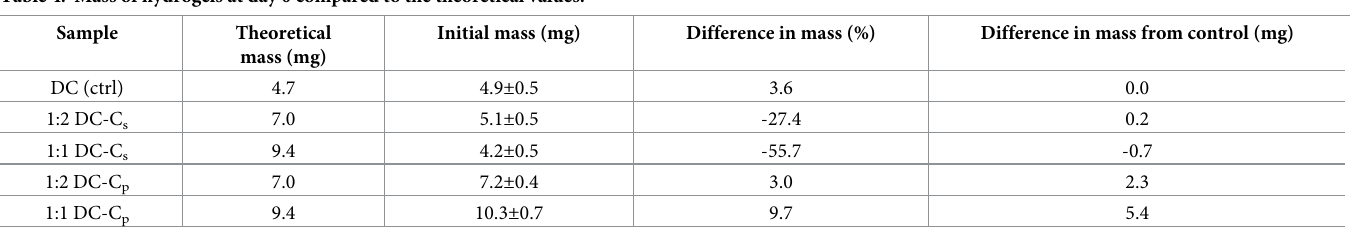
Fig 10. Mass of DC, DC-C s and DC-C p hydrogels immersed in SBF for A) 0 (as-made), B) 3 and C) 7 days ( � —statistically significant, one-way ANOVA, SD, n = 4, p < 0.05). https://doi.org/10.1371/journal.pone.0219429.g010 Table 4. Mass of hydrogels at day 0 compared to the theoretical